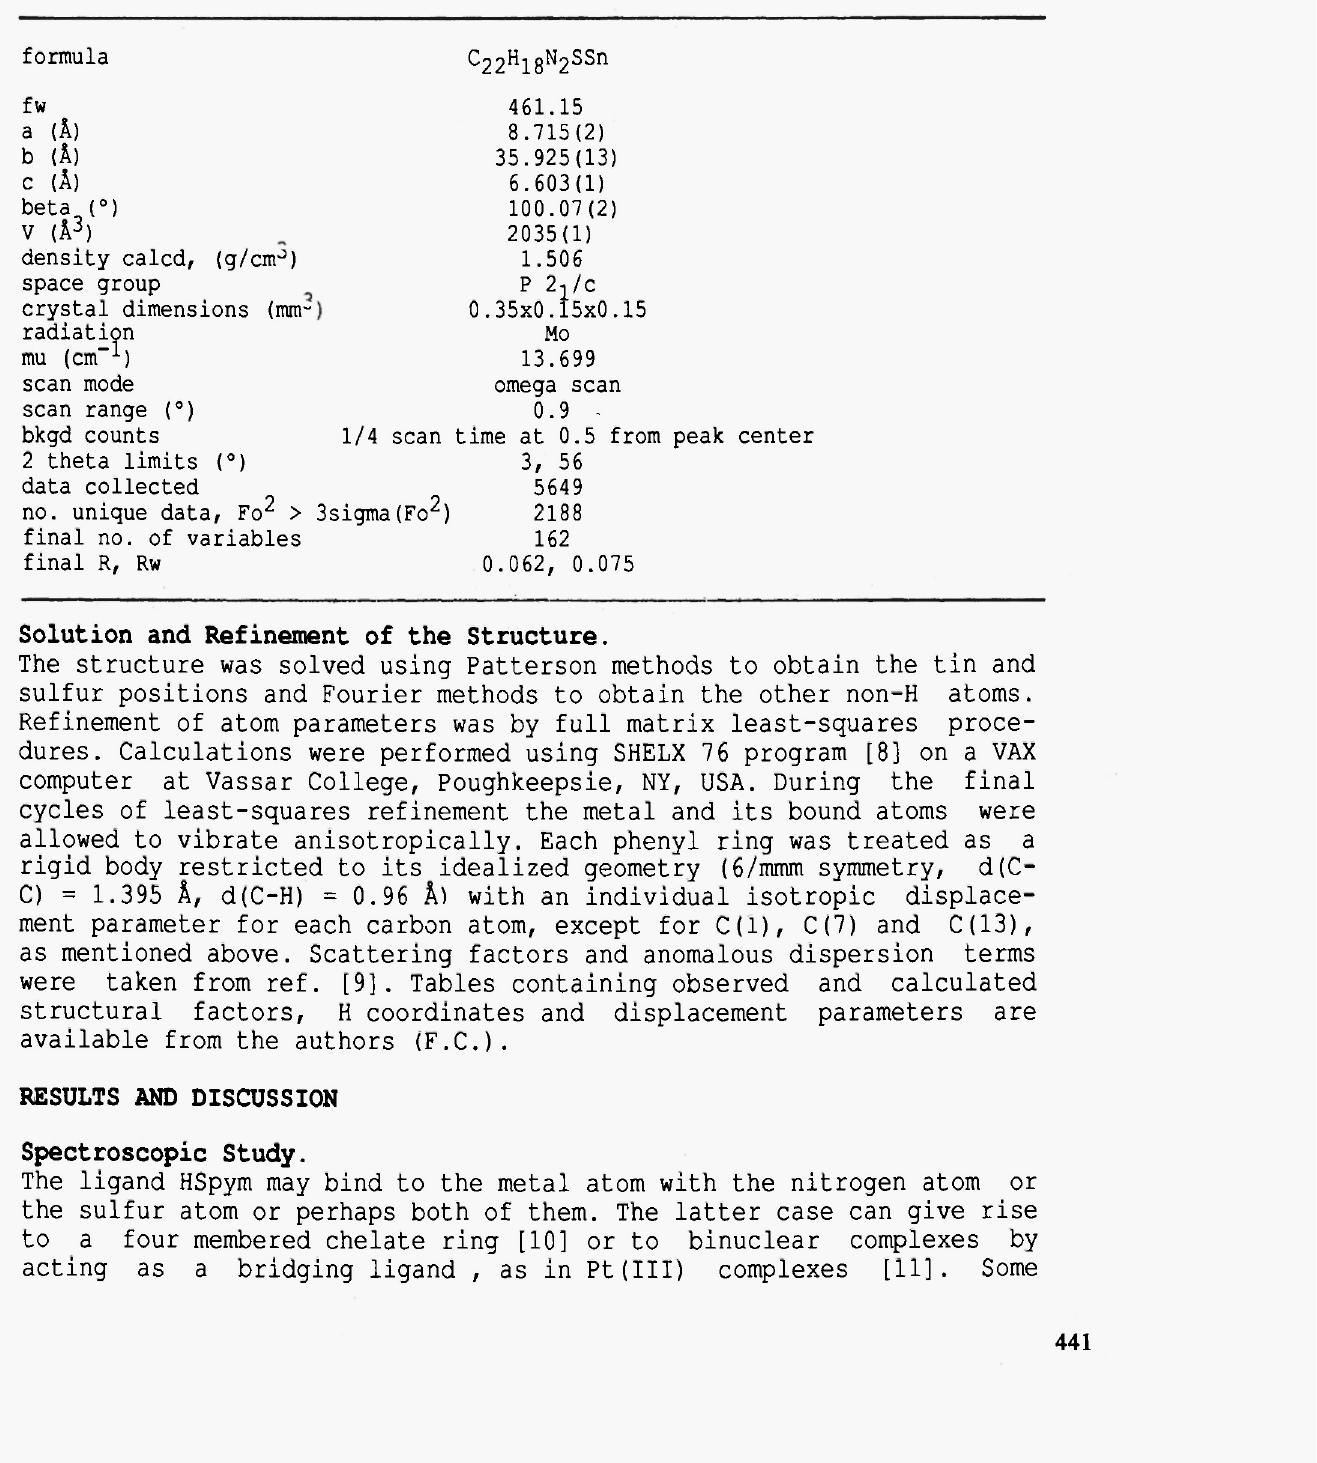
Table 2. Crystal Data and Intensity Collection Details.